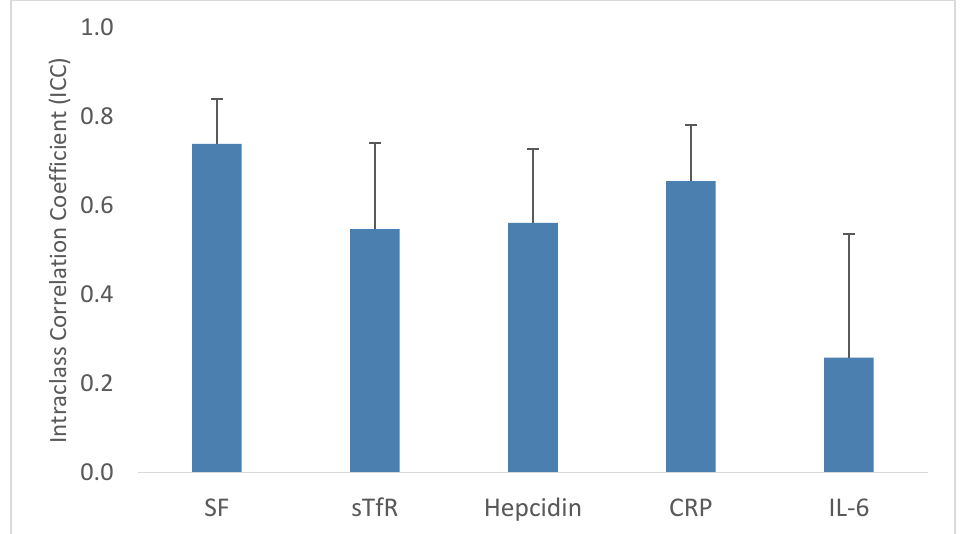
Figure 3. Neonatal iron biomarker intraclass correlation coefficients (ICCs). Bar height indicates the ICC for each biomarker calculated in mixed-effects linear regression models with a random effect for twin pair. Error bars are 95% confidence interval upper bounds from the same model. Abbreviations: CRP, c-reactive protein; IL-6, interleukin-6; SF, serum ferritin; sTfR, soluble transferrin receptor. Table 4. Predictors of intrauterine variability in log-transformed iron biomarkers.